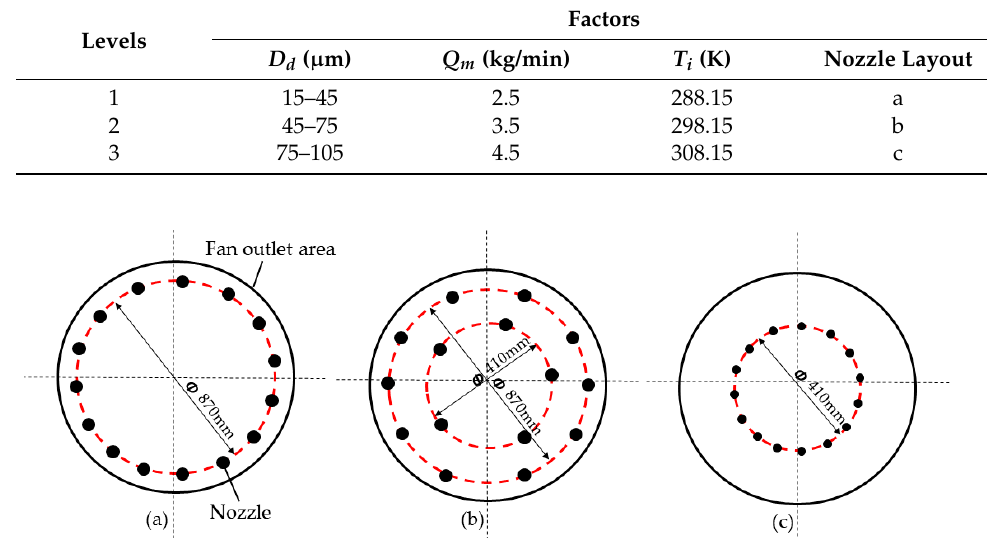
Table 3. Levels of orthogonal experimental factors.